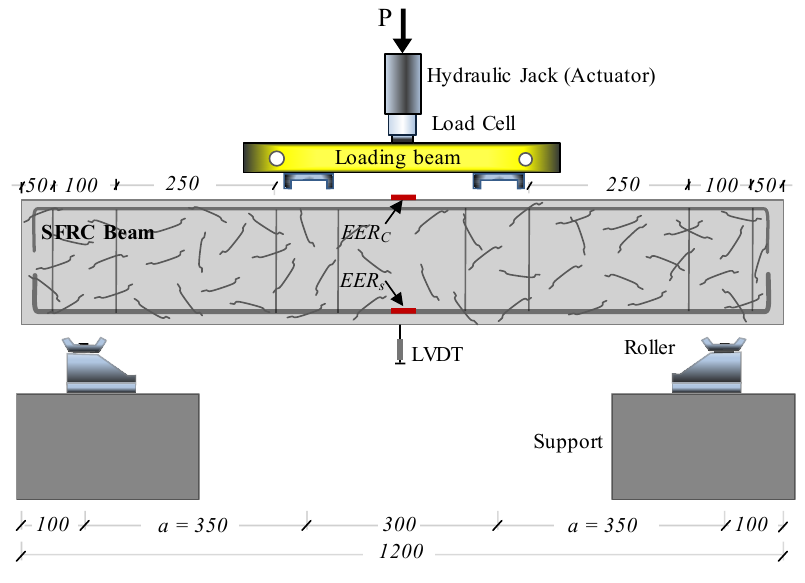
Figure 3. Test schema.